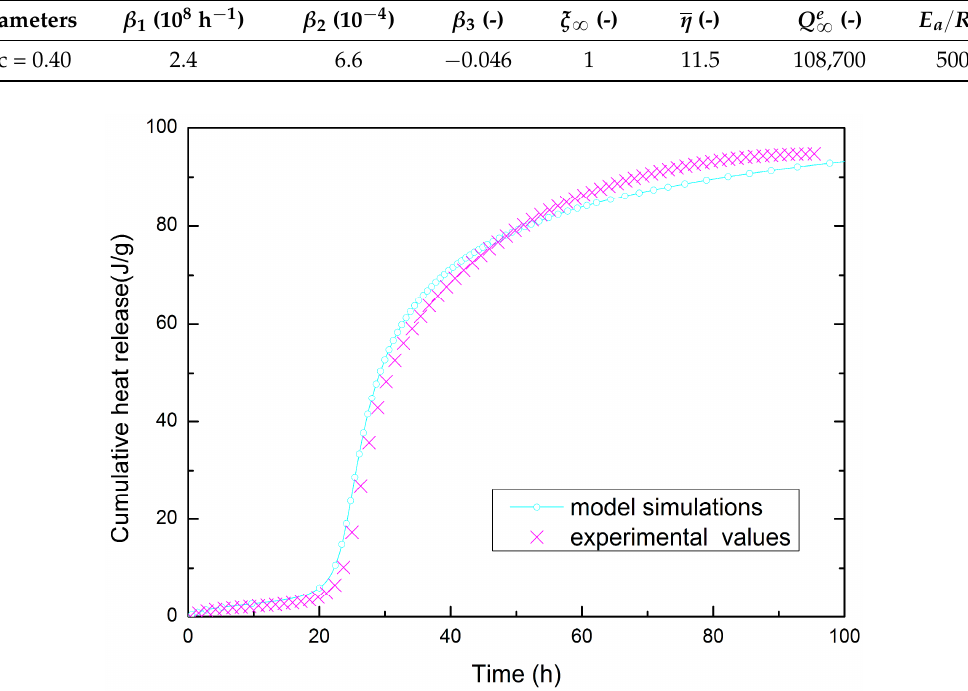
Table 4. Parameters of the hydrothermal model of SSC paste.